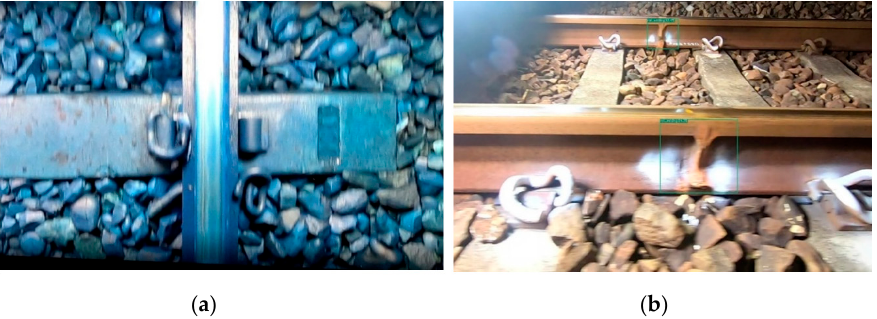
Figure 13. Some false examples. (a) too blur to identify; (b) multiple detection of Rail_welding_O. Table 15. YOLOX-Tiny re-training performance in the top view and the side view.